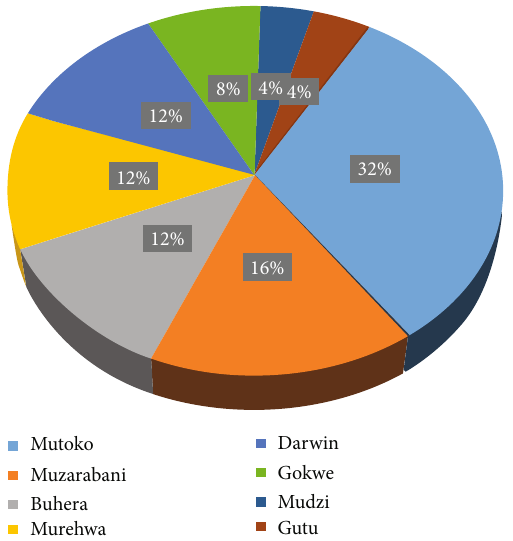
Figure 2: The region of source of peanuts and percentage of vendors who sourced peanuts from the region for sale at Mbare musika market.